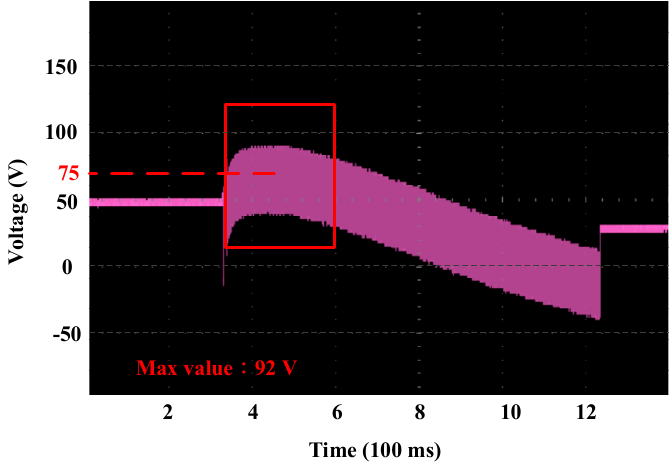
Figure 10. Response of capacitor voltage.